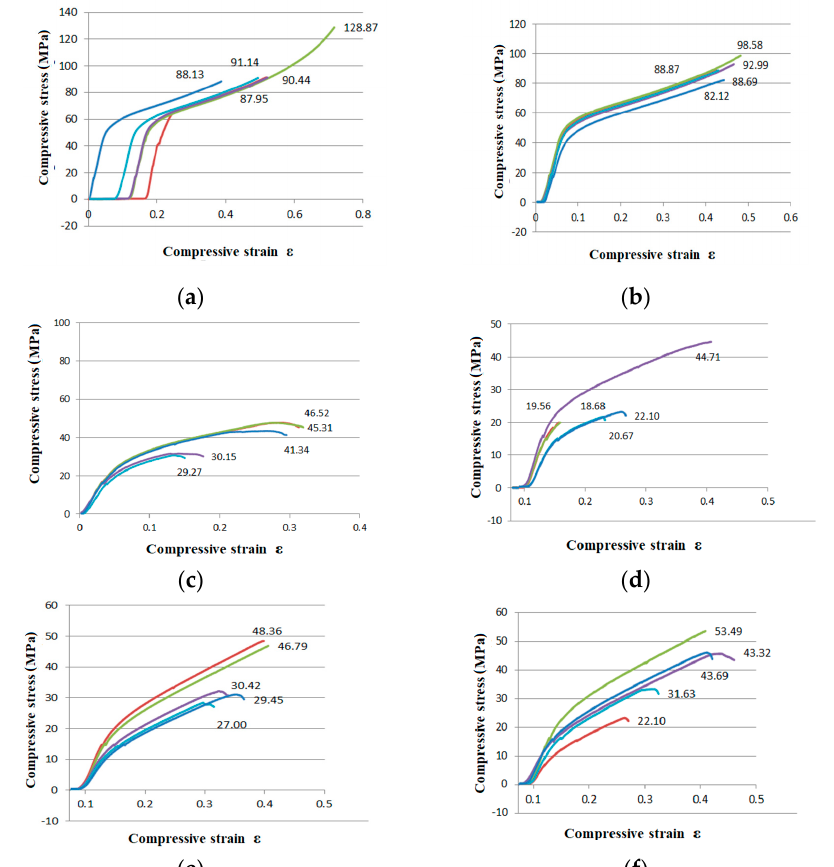
Figure 4. Results of the compressive test experiments: ( a ) first batch series; ( b ) second batch series; ( c ) third batch series; ( d ) fourth batch series; ( e ) fifth batch series (oriented around the z-axis at − 45°; ( f ) sixth batch series (oriented around the z-axis at 45°).